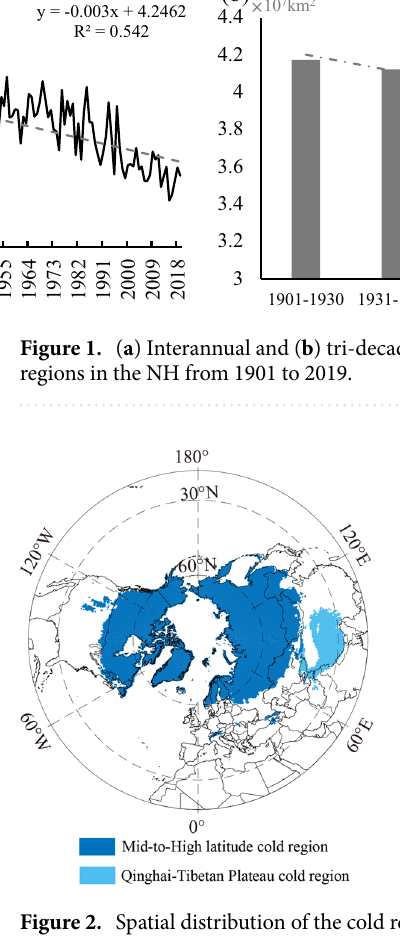
regions in the NH, the Mid-to-High latitude cold regions and Qinghai-Tibetan Plateau cold regions were ana- lyzed separately. Variation characteristics of the Mid-to-High latitude cold regions. Area of the Mid‑to‑High lati‑ tude cold regions. In the past 119 years, the mean spatial extent of the Mid-to-High latitude cold regions was about 3.755 × 10 7 km 2 , taking up 34.86% of the total land area in the NH. The rate of change in the spatial ex- tent of this region was − 0.028 × 10 7 km 2 /10 a (Fig. 3a), showing a very significant declining trend ( P < 0.001). The spatial extent of this cold region decreased continuously between the four tri-decadal climatic periods 1–4 (Fig. 3b). When comparing Period 1 and Period 4, the cold regions have decreased by 0.275 × 10 7 km 2 , which is 7.13% of the cold regions in Period 1 (Table 2). The anomalies in the spatial extent of the Mid-to-High latitude cold regions from 1901 to 2019 are shown in Fig. 3c. In 1985, a turning point from a positive to a negative anomaly was observed. The spatial extents of the Mid-to-High latitude cold regions were 3.819 × 10 7 km 2 and 3.596 × 10 7 km 2 in the periods of 1901–1985 and 1986–2019, respectively. After 1985, the spatial extent of this region decreased by 0.223 × 10 7 km 2 . Meanwhile, the linear rates of shrinkage of the Mid-to-High latitude cold regions in 1901–1985 and 1986–2019 were calculated as − 0.011 × 10 7 km 2 /10 a ( P < 0.01) and − 0.066 × 10 7 km 2 /10 a ( P < 0.001), respectively, showing a significant declining trend. After 1985, this rate of loss accelerated significantly, being six times faster than before 1985. Spatial distribution of the Mid‑to‑High latitude cold regions. The spatial distribution of the Mid-to-High lati- tude cold regions of the NH from 1901 to 2019 is shown in Fig. 2. From 1901 to 2019, this region was mainly distributed in Canada, Greenland, most of Iceland, Alaska, and the Rocky Mountains in the United States, the Alps in central Europe, northern Eurasia, and the great Caucasus. In addition, the mean southern boundary of this region was around 49.48° N from 1901 to 2019 (Table 2), showing an irregular variation in longitude. Variation exists in the distribution of this region at different longitudes. The southern boundary of this cold region was the lowest at 106° W, at about 36.50° N. Furthermore, the southern boundary of the cold regions was around 60° N at 15.75° E, with a difference of nearly 23.5° in latitude. In general, the southern boundary of the